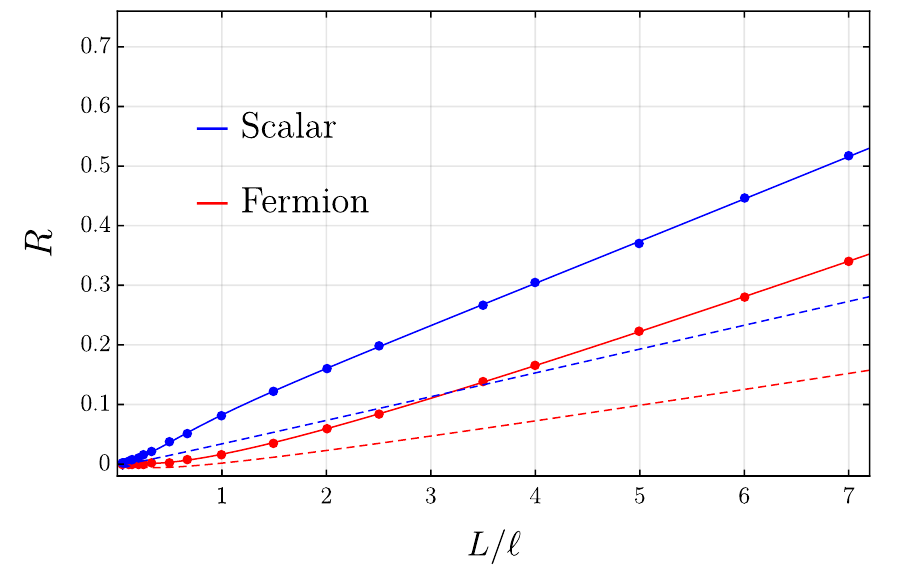
Figure 5 . We plot the reflected entropy (per degree of freedom) for regions A , B , corresponding to two squares of length L separated by a distance ‘ as a function of L/‘ for a free scalar (blue) and a free fermion (red). For both fields we also plot the mutual information I ( A, B ) for the same pair of regions (dashed lines). The latter curves are obtained numerically using the usual definition I ( A, B ) = S ( A ) + S ( B ) − S ( AB ) , where the corresponding entanglement EE EE EE